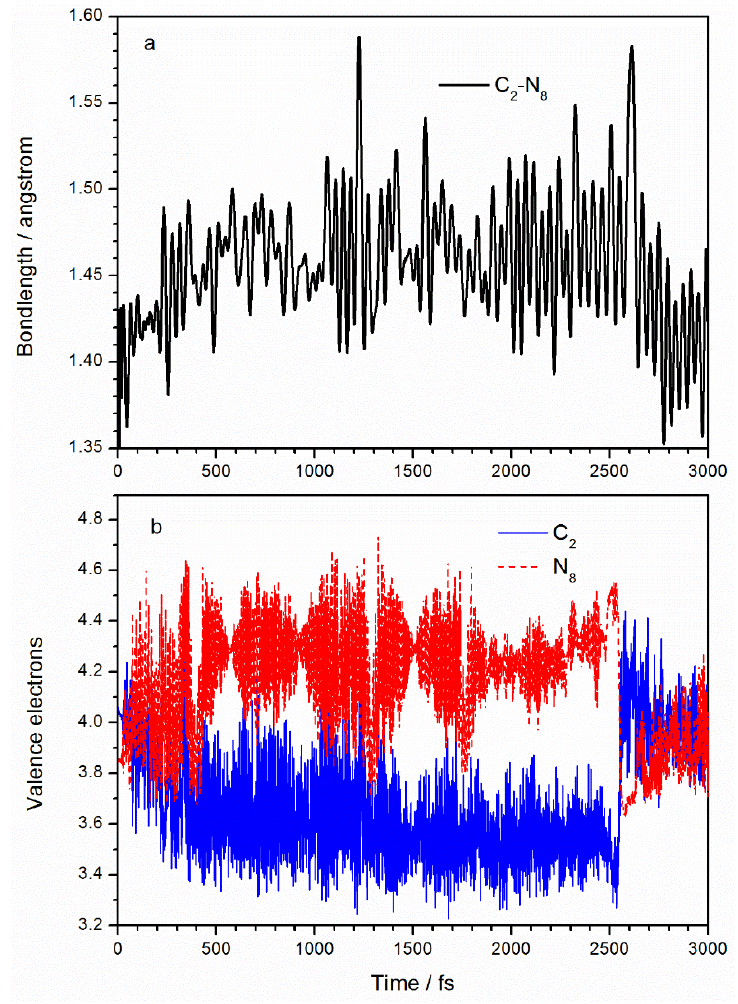
Figure 3. Variations with time of ( a ) C 2 –N 8 bond length and ( b ) valence electrons of C 2 and N 8 atoms in the activated nitro group.